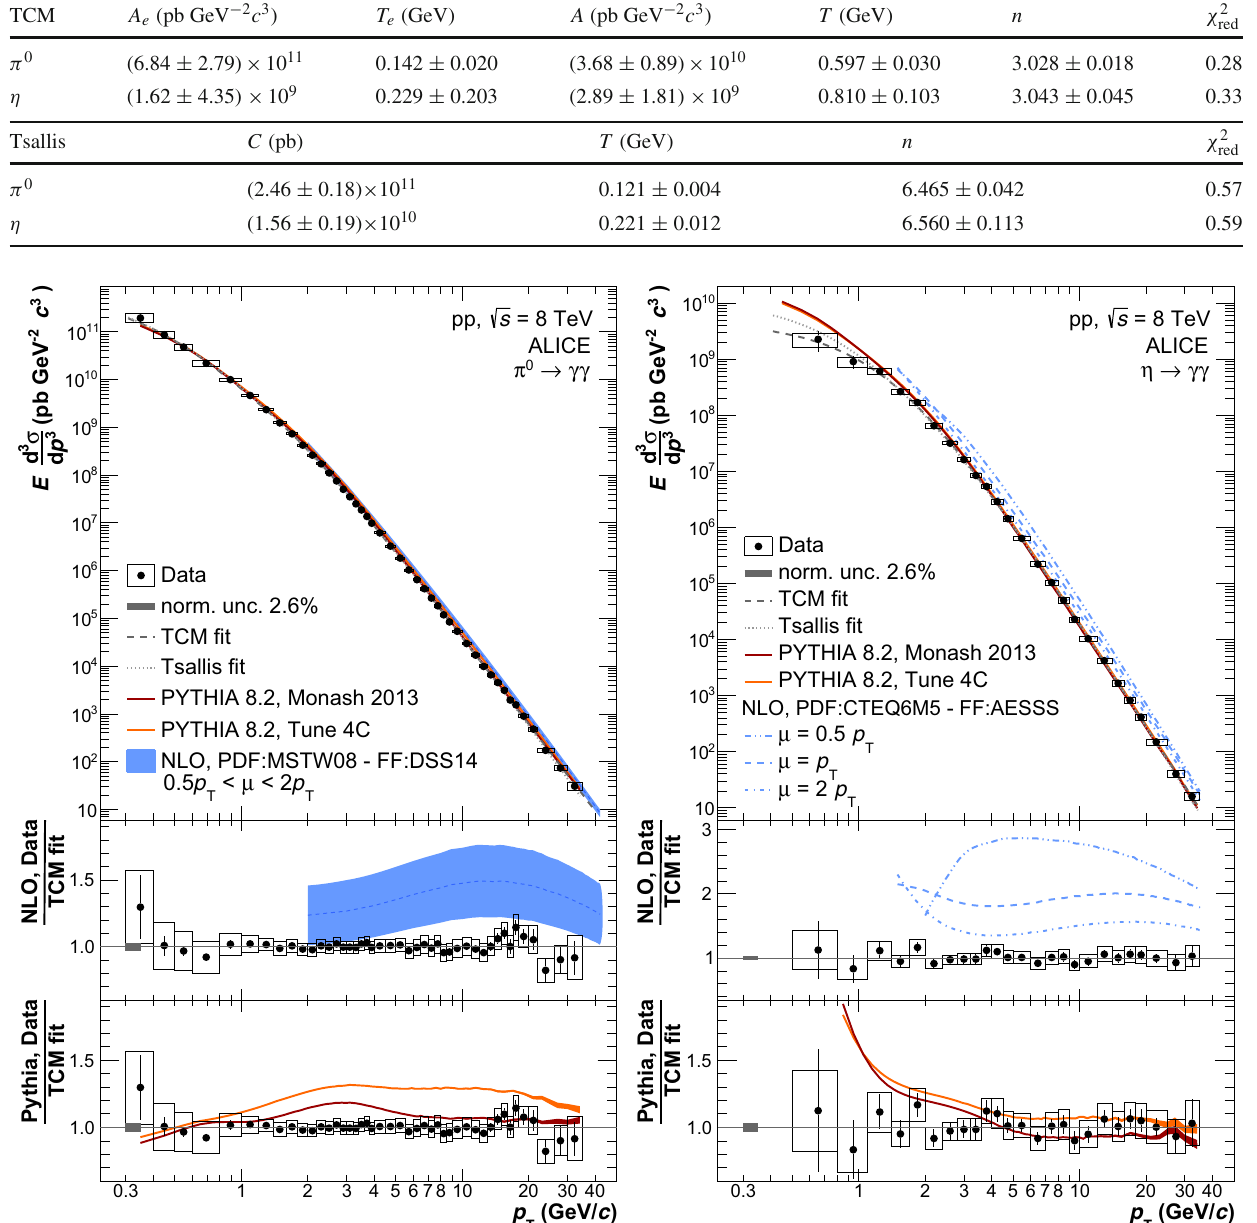
Table 5 Parameters of the fits to the π 0 and η invariant differential cross sections using the TCM fit [55] from Eq. 3 as well as using a Tsallis fit